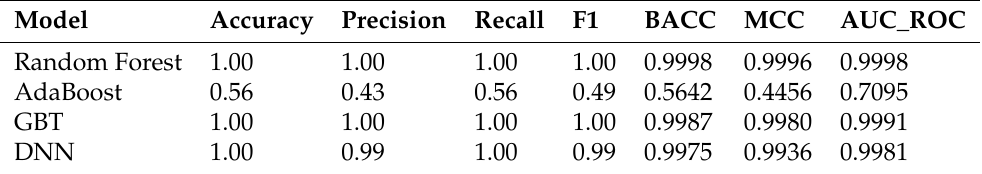
Table 11. Comparison of the models used and their prediction results on test data with